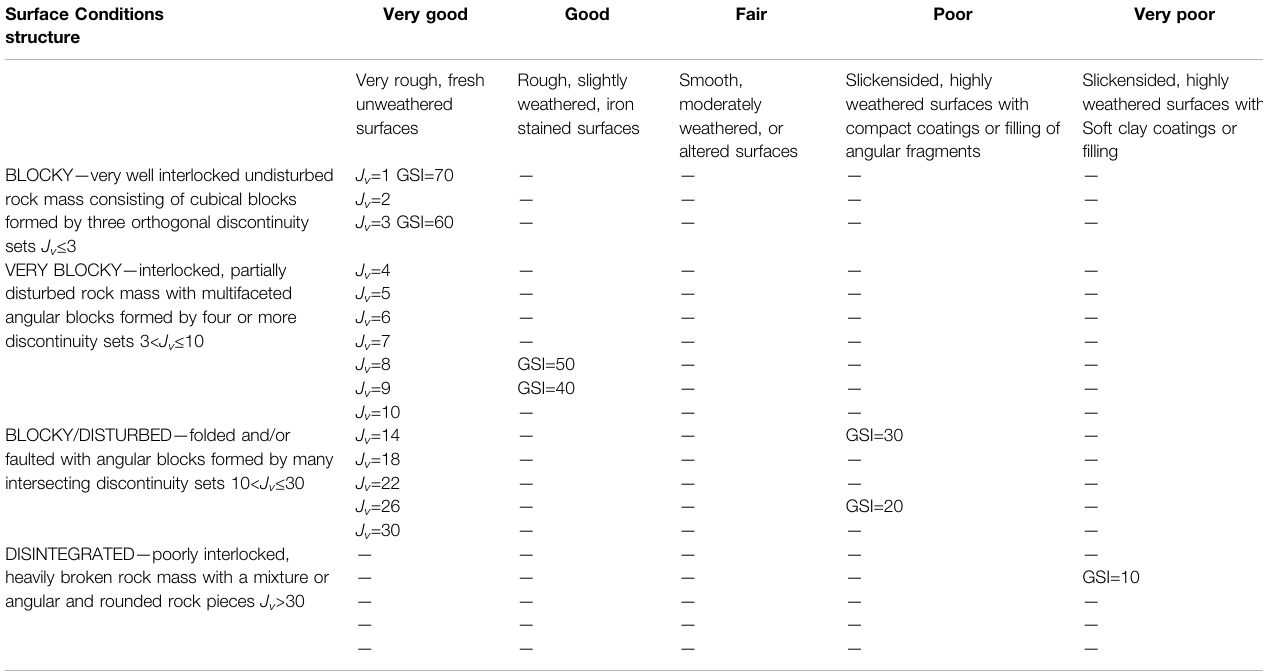
TABLE 3 | Geological Strength Index (GSI) estimates based on geological descriptions (Hoek and Brown, 2019).